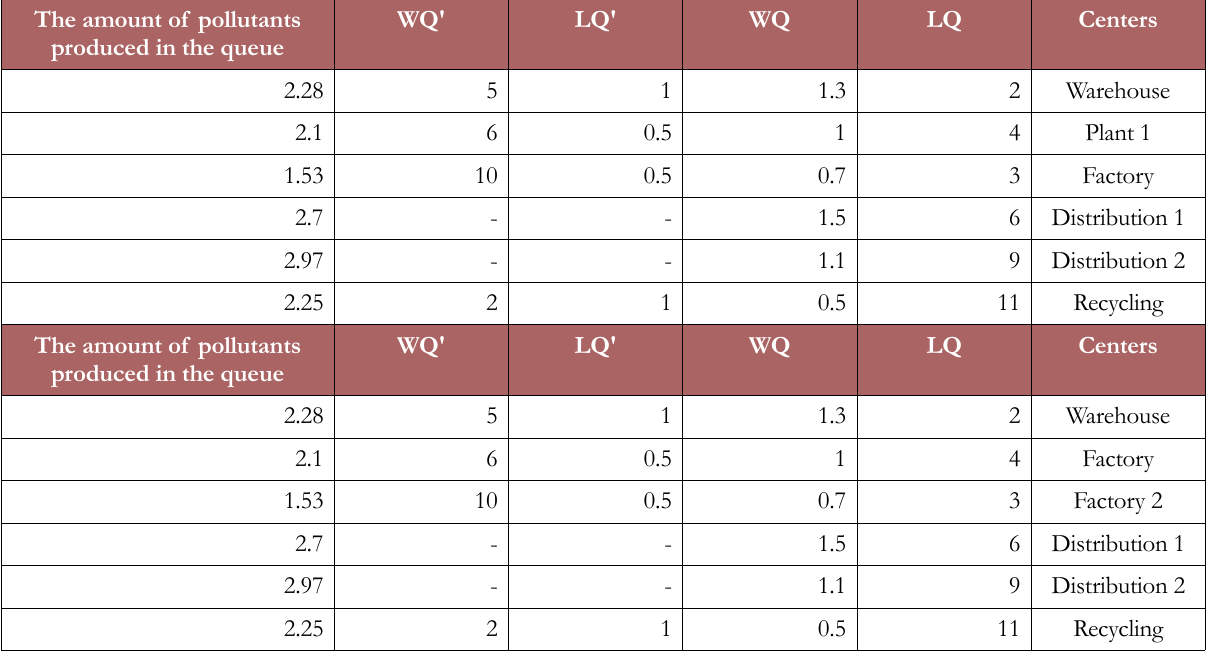
Table 3. The amount of pollutants produced by the transportation fleet according to the distance between the two centers of and the required